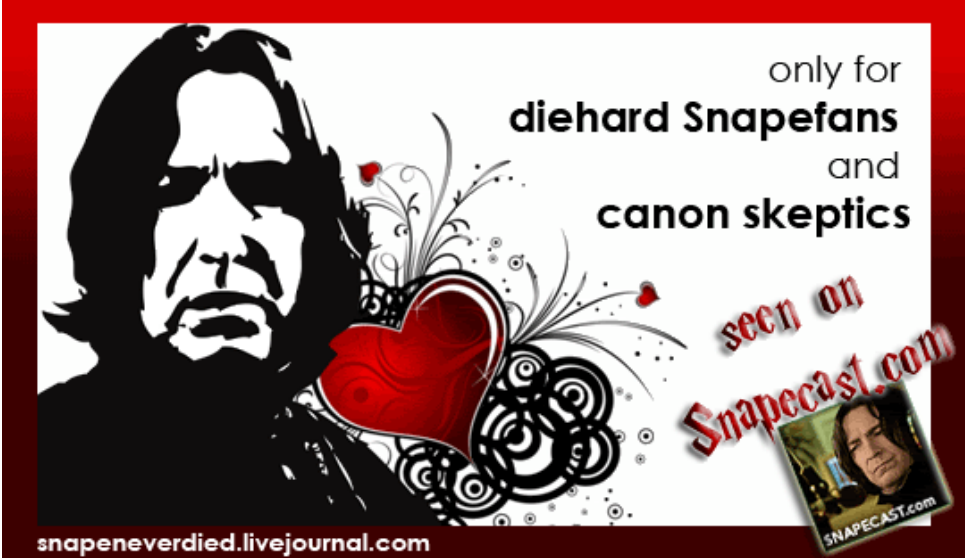
Figure 10. Advertisement for the Snape Never Died community